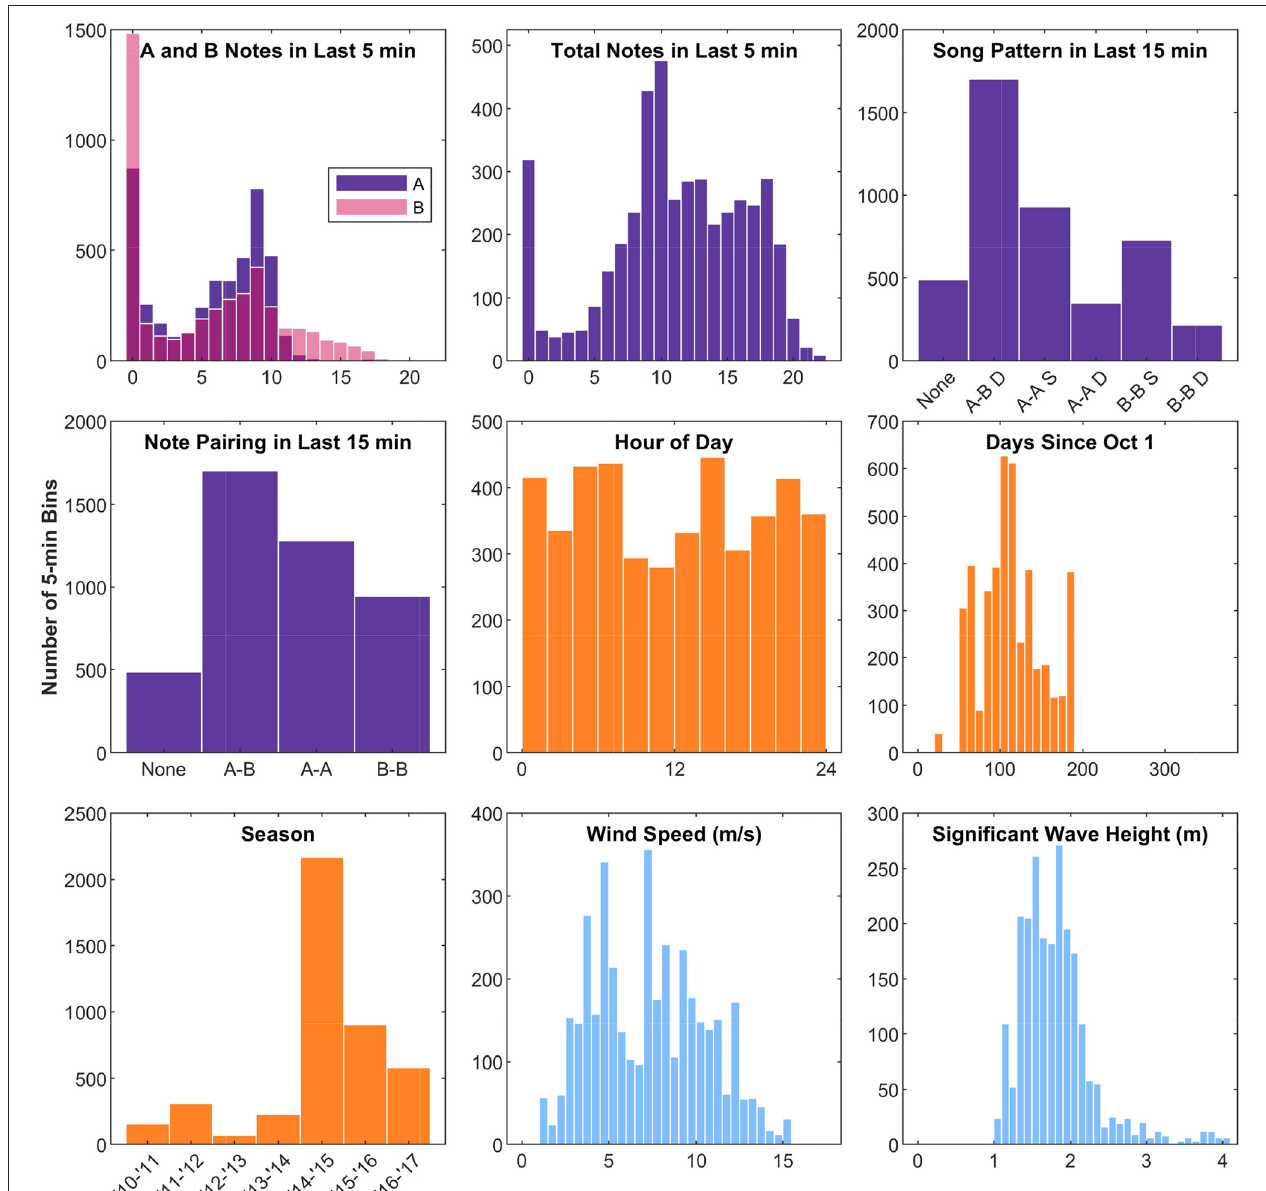
FIGURE 4 | Histograms of the independent variables observed during fin whale song tracks. The y-axis counts are the number of 5-min bins. Song pattern variables are shown in purple/pink, time variables are shown in orange, and environmental variables are shown in blue. For the plot of song pattern in the last 15 min, D stands for doublet and S stands for singlet. Hour of Day is in local Hawaii Standard Time. The x-axes limits for the plots of time and environmental variables match the corresponding plots in Figure 7